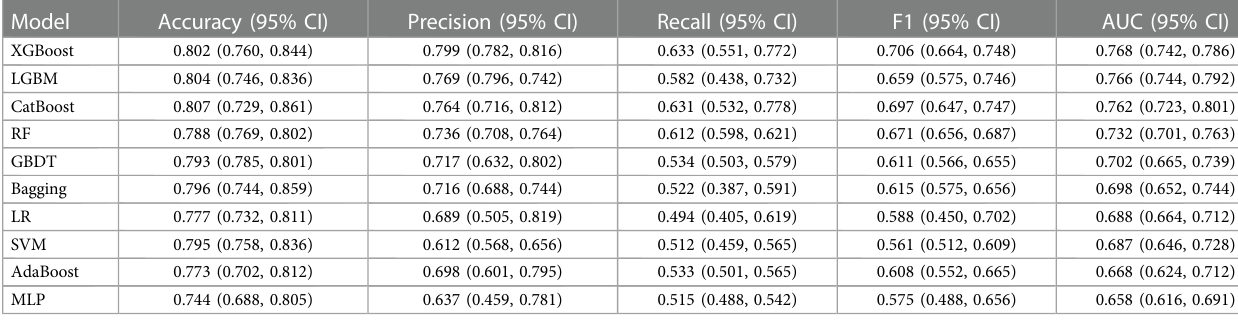
TABLE 2 Performance summary of machine learning models in CMP-IV group.